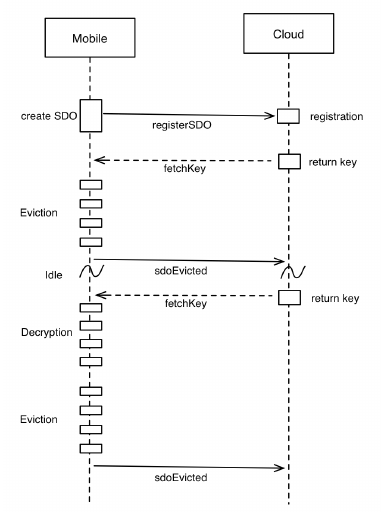
Figure 1: CleanOS communication between phone and cloud for the one time, initial registration of an SDO (top part) and subsequent, frequent, regular data access and key eviction